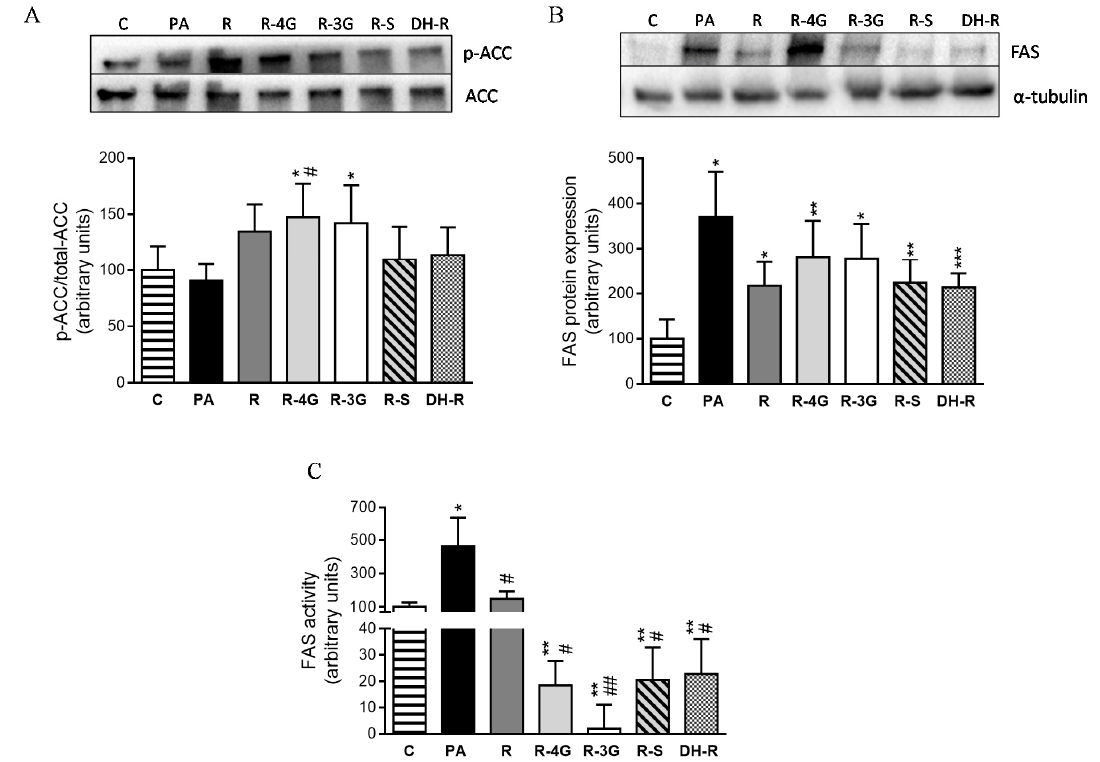
Figure 6. p-ACC / total-ACC ratio (index of ACC activity) ( A ), protein expression of FAS ( B ) and FAS activity ( C ) in AML12 hepatocytes incubated with 0.3 M palmitic acid (PA), with or without resveratrol or its metabolites (R-4G, R-3G, R-S and DH-R) at 1 µ M. The western blot bands shown are representative of 6 samples / group. Data are means ± SEM. * p < 0.05, and ** p < 0.01 vs. the control cells. # p < 0.05 and ## p < 0.01 vs. PA group. ACC: Acetyl-CoA carboxylase; FAS; fatty acid synthase.